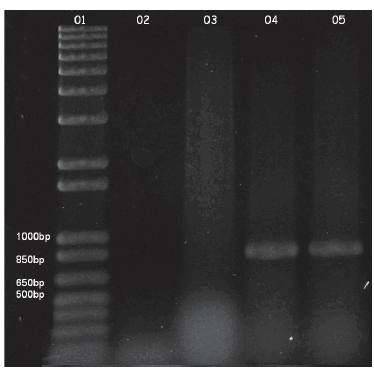
FIGURE 2 - Amplification of the eae gene from enteropathogenic Escherichia coli strains used in the experiment and from strain E. coli TOP10 used as negative control in PCR on 0.8% agarose gel. 01: Base pair marker 1 kb Plus (Invitrogen). 02: Negative control (without DNA). 03: E. coli strain TOP10 (saprophytic). 04: Strain SPA14. 05: Strain 4083.